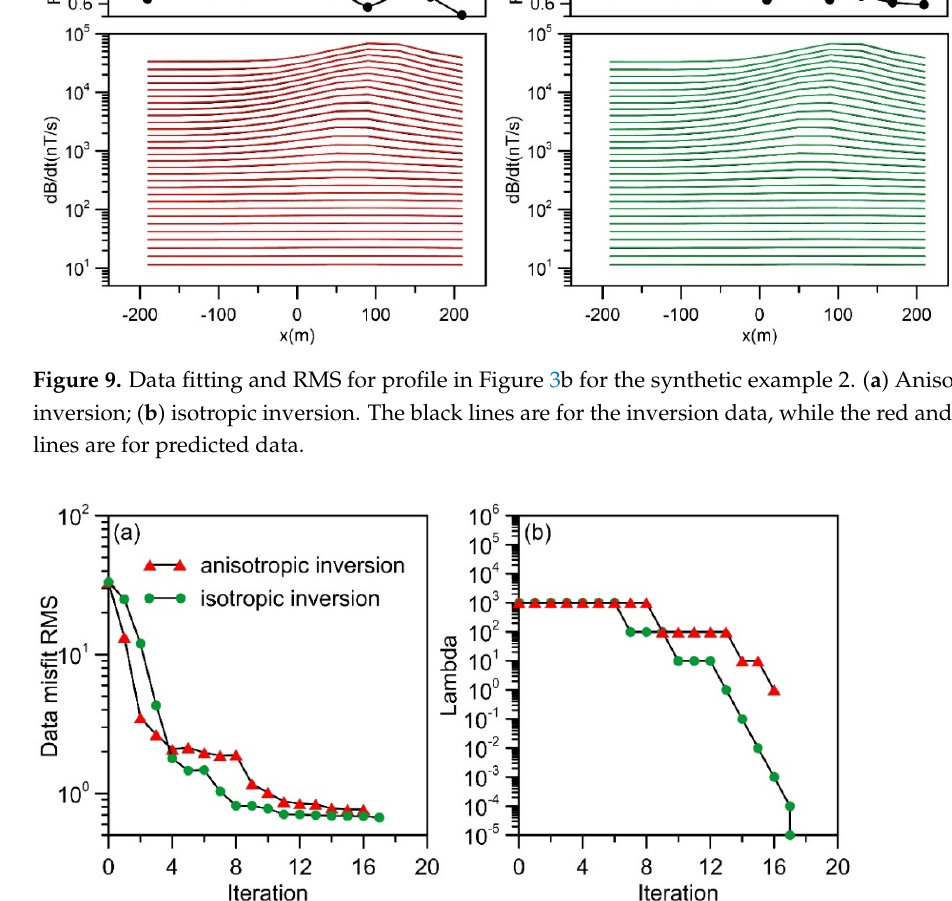
Figure 10. Plots of inversion parameters for the inversion of synthetic example 2. ( a ) Data misfit RMS; ( b ) regularization parameter λ .